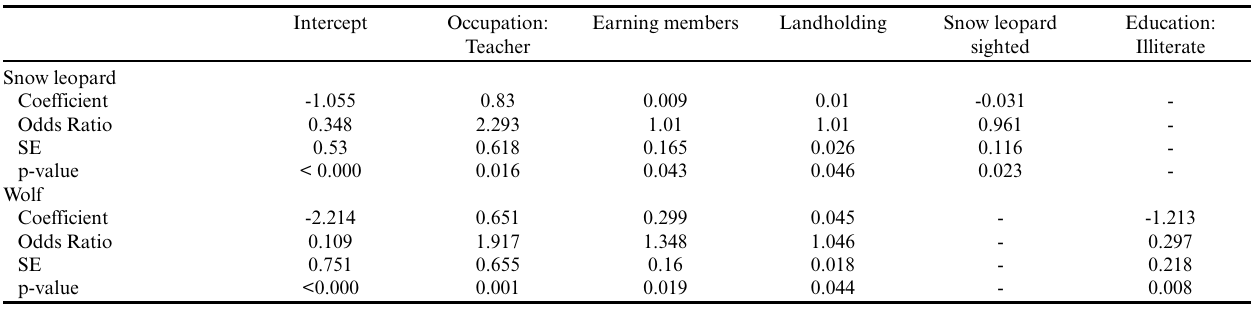
Table 5 . Factors affecting attitudes toward snow leopards ( Panthera uncia ) and wolves ( Canis lupus ) in the study sites. (Parameters are estimated by lasso regression